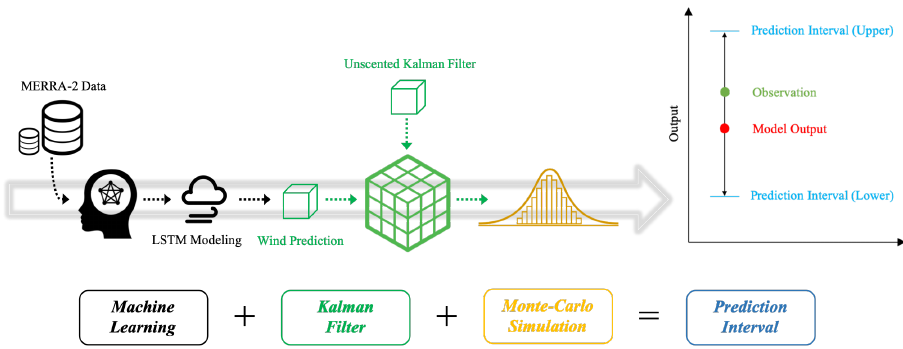
Figure 7. Notional sketch of the MCS-based UQ process